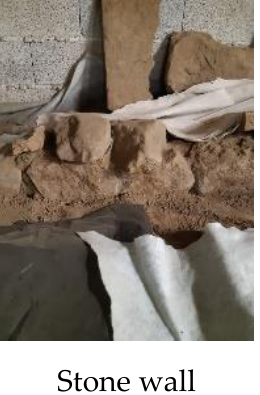
Figure 2. Funerary enclosure, graves and stone wall of the funerary nucleus.